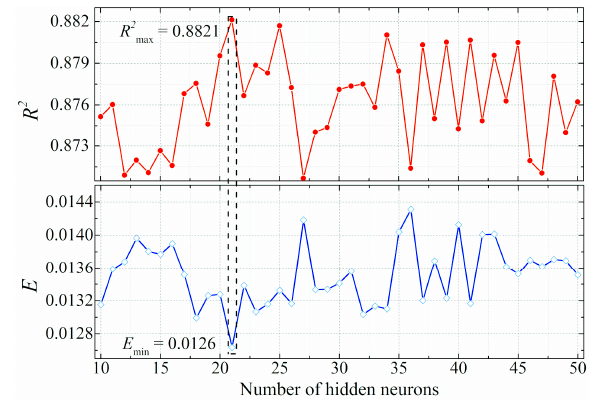
Figure 5. Comparison of artificial neural network (ANN) architectures.